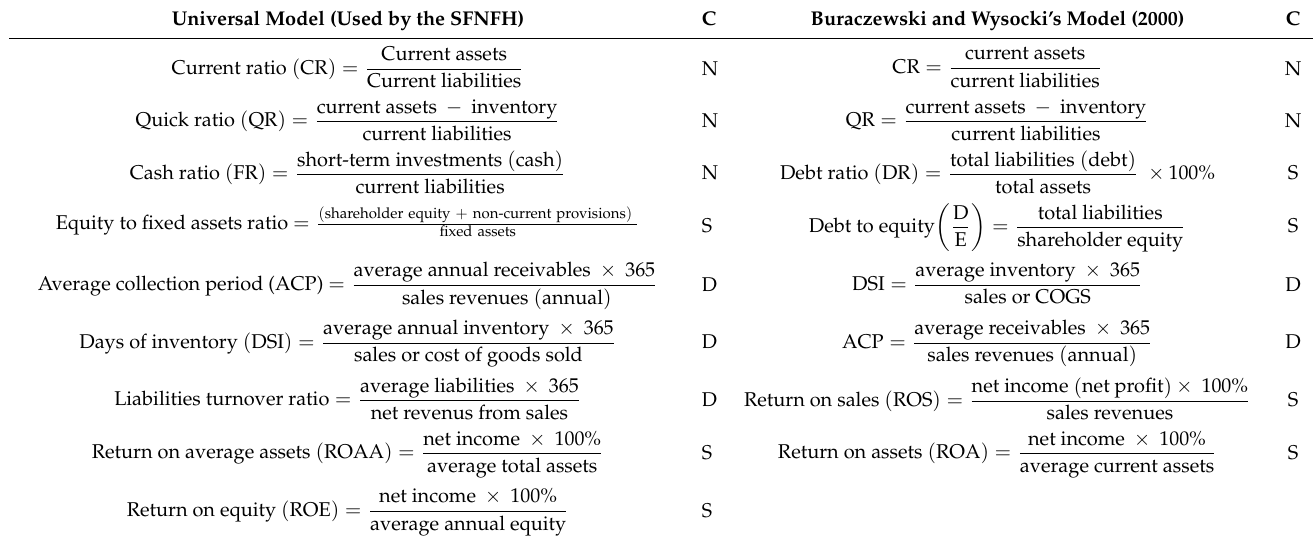
Table 1. Indicators used in ratio analysis and in developing synthetic